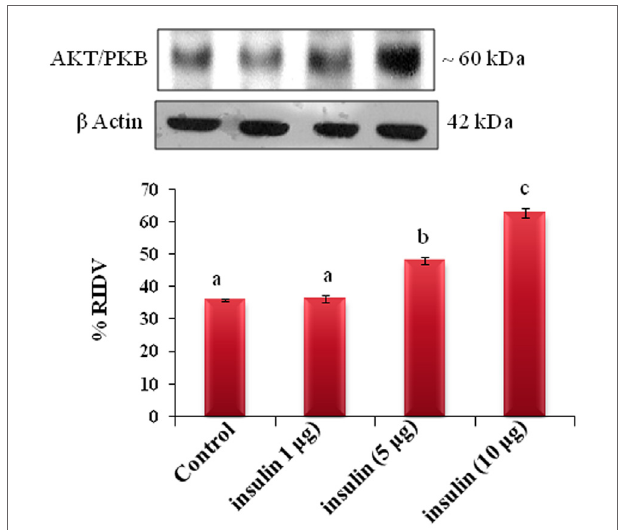
FigUre 6 | The in vitro treatment of adipose tissue with different doses (1, 5, and 10 μ g/ml) of insulin showed dose-dependent significant (b, c, and d, p < 0.05) increase in the expression of aKT/ PKB protein in adipose tissue as compare to the control (a, p < 0.05)